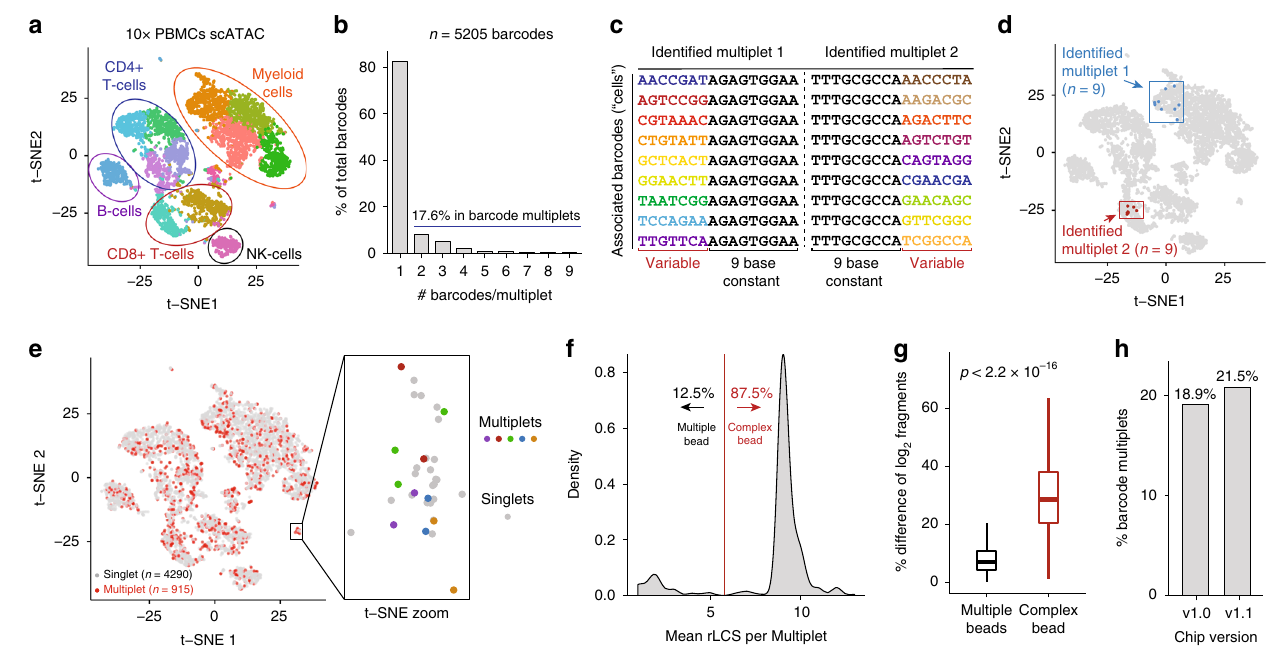
Fig. 3 Inference and effect of barcode multiplets in single-cell ATAC-seq data. a Default t-SNE depiction of public scATAC-seq PBMC 5k dataset. Colors represent cluster annotations from the automated CellRanger output. b Quanti fi cation of barcodes affected by barcode multiplets for the same dataset (identi fi ed by bap). c Depiction of two multiplets each composed of 9 oligonucleotide barcodes. Barcodes in each multiplet share a long common subsequence, denoted in black. d Visualization of two barcode multiplets from c in t-SNE coordinates. e Visualization of all implicated barcode multiplets from this dataset. The zoomed panel shows a small group of cells affected by fi ve multiplets, indicated by color. f Empirical distribution of the mean restricted longest common subsequence (rLCS) per multiplet. A cutoff of 6 was used to determine either of the two classes of barcode multiplets. g Percent difference of the mean log2 fragments between pairs of barcodes within a multiplet. The reported p-value is from a two-sided Kolmogorov – Smirnov test. The exact p -value is lower than machine precision. Analysis represents n = 5205 barcodes over 1 experimental replicate. Boxplots: center line, median; box limits, fi rst and third quartiles; whiskers, 1.5× interquartile range. h Overall rates of barcode multiplets from additional scATAC-seq data comparing v1.0 and v1.1 (NextGEM) chip designs. Source data are available in the Source Data fi